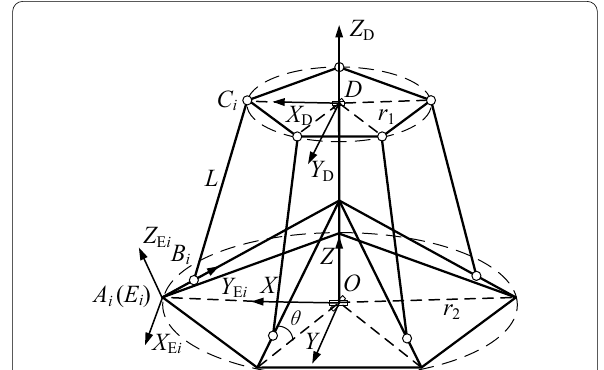
Figure 2 Structure diagram of 5-PSS/UPU parallel